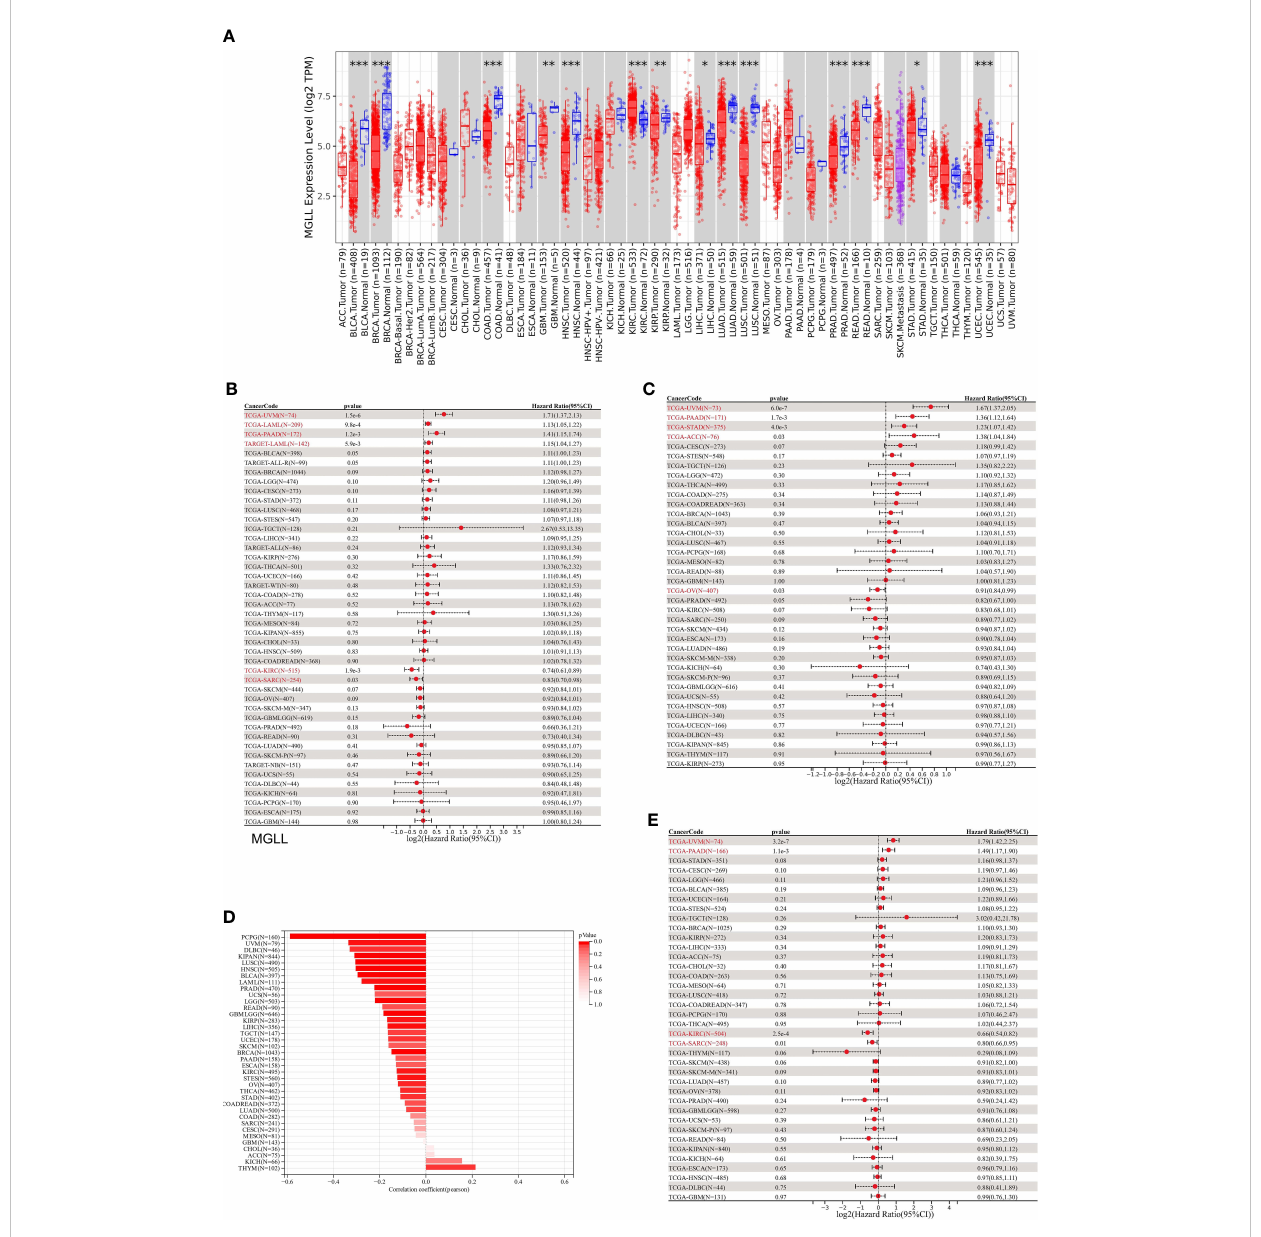
FIGURE 7 A correlation between MGLL and prognosis in pan-cancer samples. (A) Expression levels of MGLL across pan-cancer samples in the TCGA dataset. (http://timer.cistrome.org/) (B) Cox regression model study of MGLL expression and OS in the UCSC dataset. (C) Cox regression model-based analysis of PFS and MGLL expression. (D) Cox regression analysis of MGLL expression with DSS in different types of tumor. (E) MGLL expression and tumor purity were correlated using the ESTIMATE algorithm in the UCSC dataset. DSS, disease-speci fi c survival; PFS, progression-free survival. *p < 0.05; **p < 0.01; ***p <